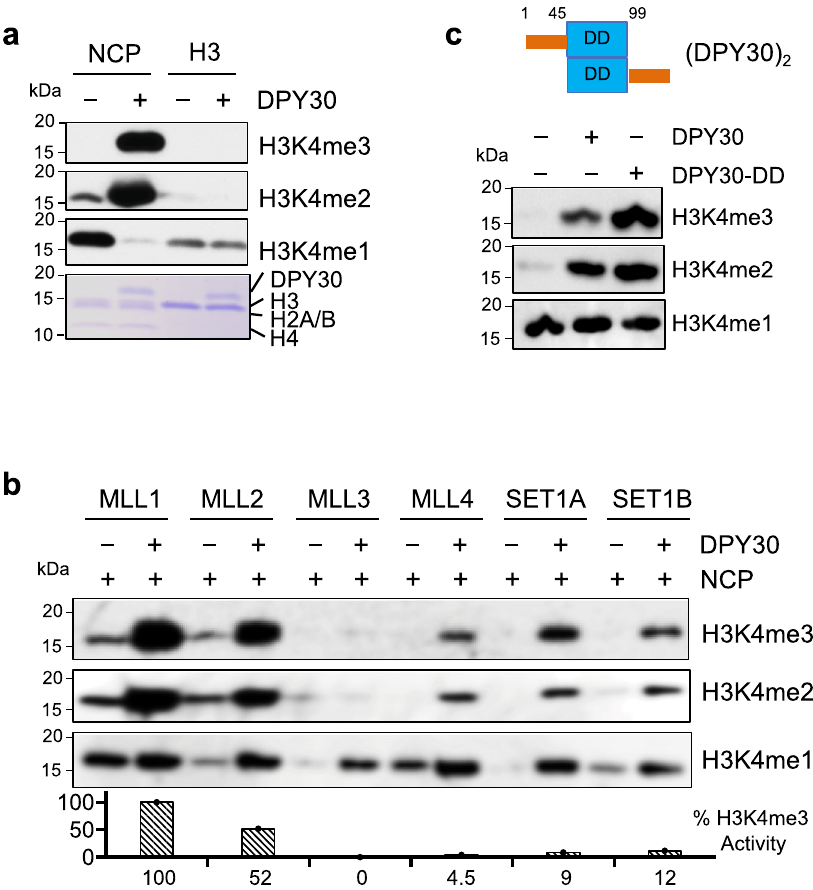
Fig. 1 DPY30 speci fi cally stimulates MLL1 activity on the NCP. a In vitro HMT assay for the MLL1 core complex using either the NCP (nucleosome core particle) or recombinant histone H3 as substrates, which were indicated on top. The MLL1 core complex (i.e., MLL1 SET , WDR5, RbBP5, and ASH2L) was added with or without DPY30. Histones were run on 15% SDS-PAGE and blotted with anti-H3K4me1, H3K4me2, and H3K4me3 antibodies as indicated at right. The Coomassie gel was included as the loading control at bottom. b In vitro HMT assay for the core complexes of the MLL/SET1 family methyltransferases using the NCP as the substrate. The MLL/SET1 core complexes were added with or without DPY30 as indicated on top. c Top, Domain structure for the DPY30 dimers. DD, dimerization domain (blue). Bottom, in vitro HMT assay for the MLL1 core complex with no, dimerization domain only, or full-length DPY30. The NCP was used as the substrate in all reactions. Quanti fi cation completed using ImageJ 108 with %activity calculated relative to wild-type ASH2L-containing complex 108